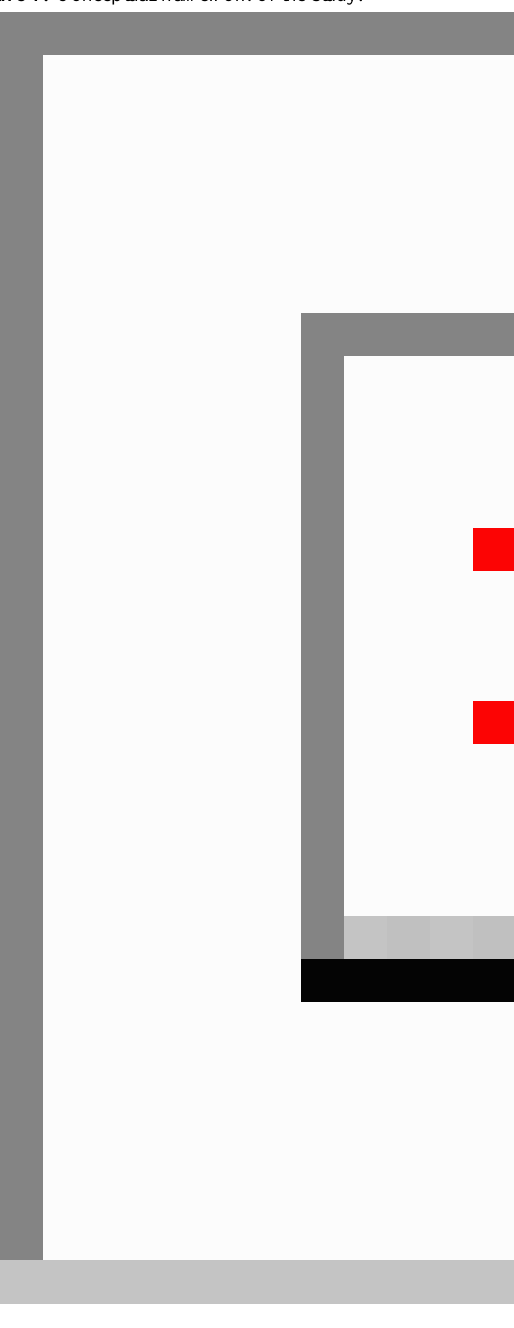
Figure 1. Conceptual framework of the